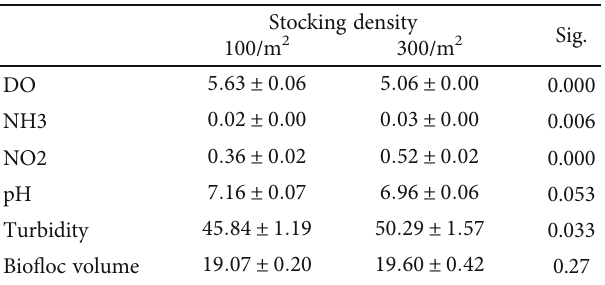
Table 5: Water quality parameters during 135 days rearing period of whiteleg shrimp under di ff erent density bio fl oc